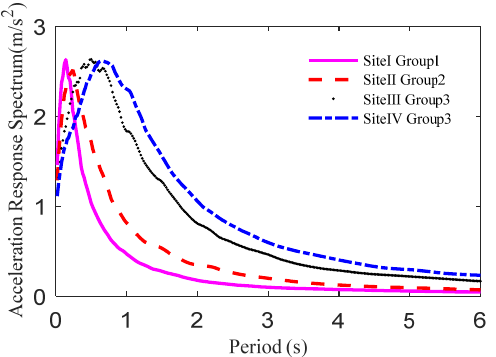
Figure 3. Mean acceleration response spectrum for different groups of simulated seismic ground motions.